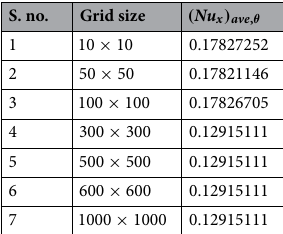
Table 3. Grid free analysis for the Nusselt number.